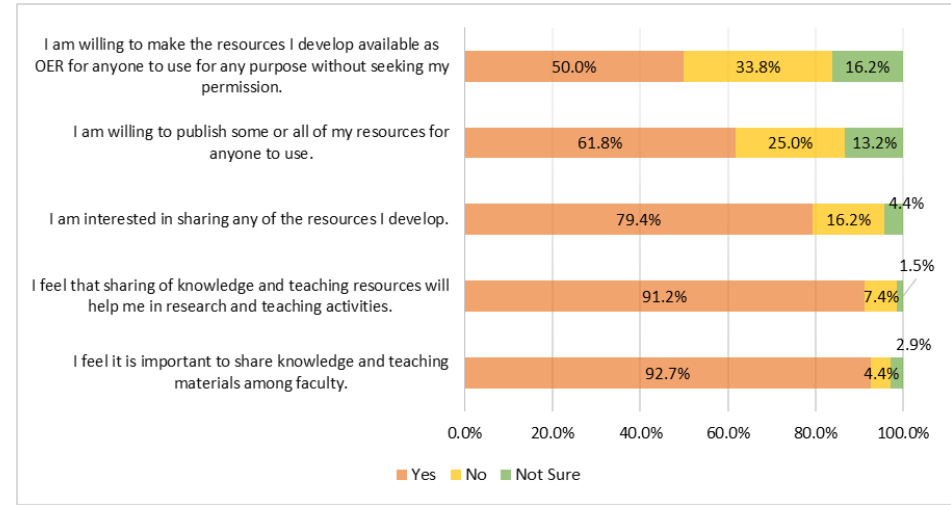
Figure 2. Intention to share knowledge and learning resources.